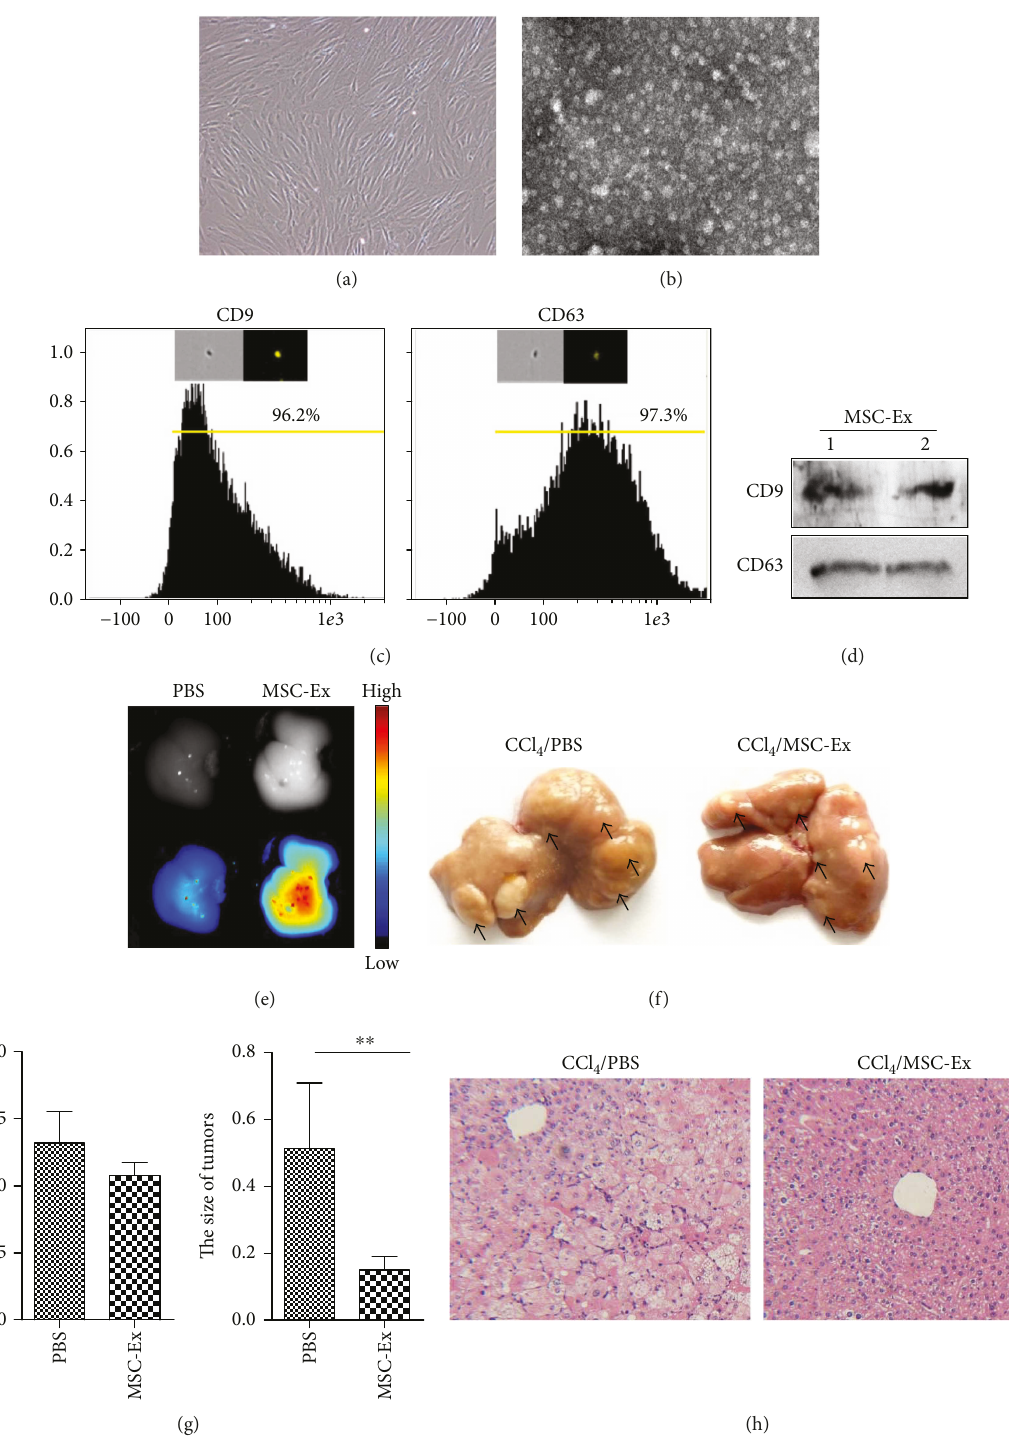
Figure 1: hucMSC-Ex suppressed CCl -induced mouse liver tumor growth. (a) Morphological appearance of cultured hucMSCs. Original 4 magni fi cation 200x. (b) Identi fi cation of hucMSC-Ex with transmission electron micrograph. Scale bar 100nm. (c) Imaging fl ow cytometer analysis of phenotypic markers of hucMSC-Ex. hucMSC-Ex were positive for CD9 and CD63. (d) Western blot assay indicated the positive expression of CD9 and CD63 proteins in hucMSC-Ex. (e) Distribution of CM-DiR labeled hucMSC-Ex in CCl hepatic carcinoma mice by in vivo fl uorescent imaging. (f) Macroscopical observation of tumors in the liver surface of mice treated with PBS or hucMSC-Ex. The arrows indicated the tumors. (g) Analysis of the number and average size of tumors in the livers. Tumor size was signi fi cantly reduced in the hucMSC-Ex group ( n = 6 ; ∗∗ P < 0 01 ). (h) Representative images of H&E staining in the livers treated with PBS or hucMSC-Ex. Original magni fi cation